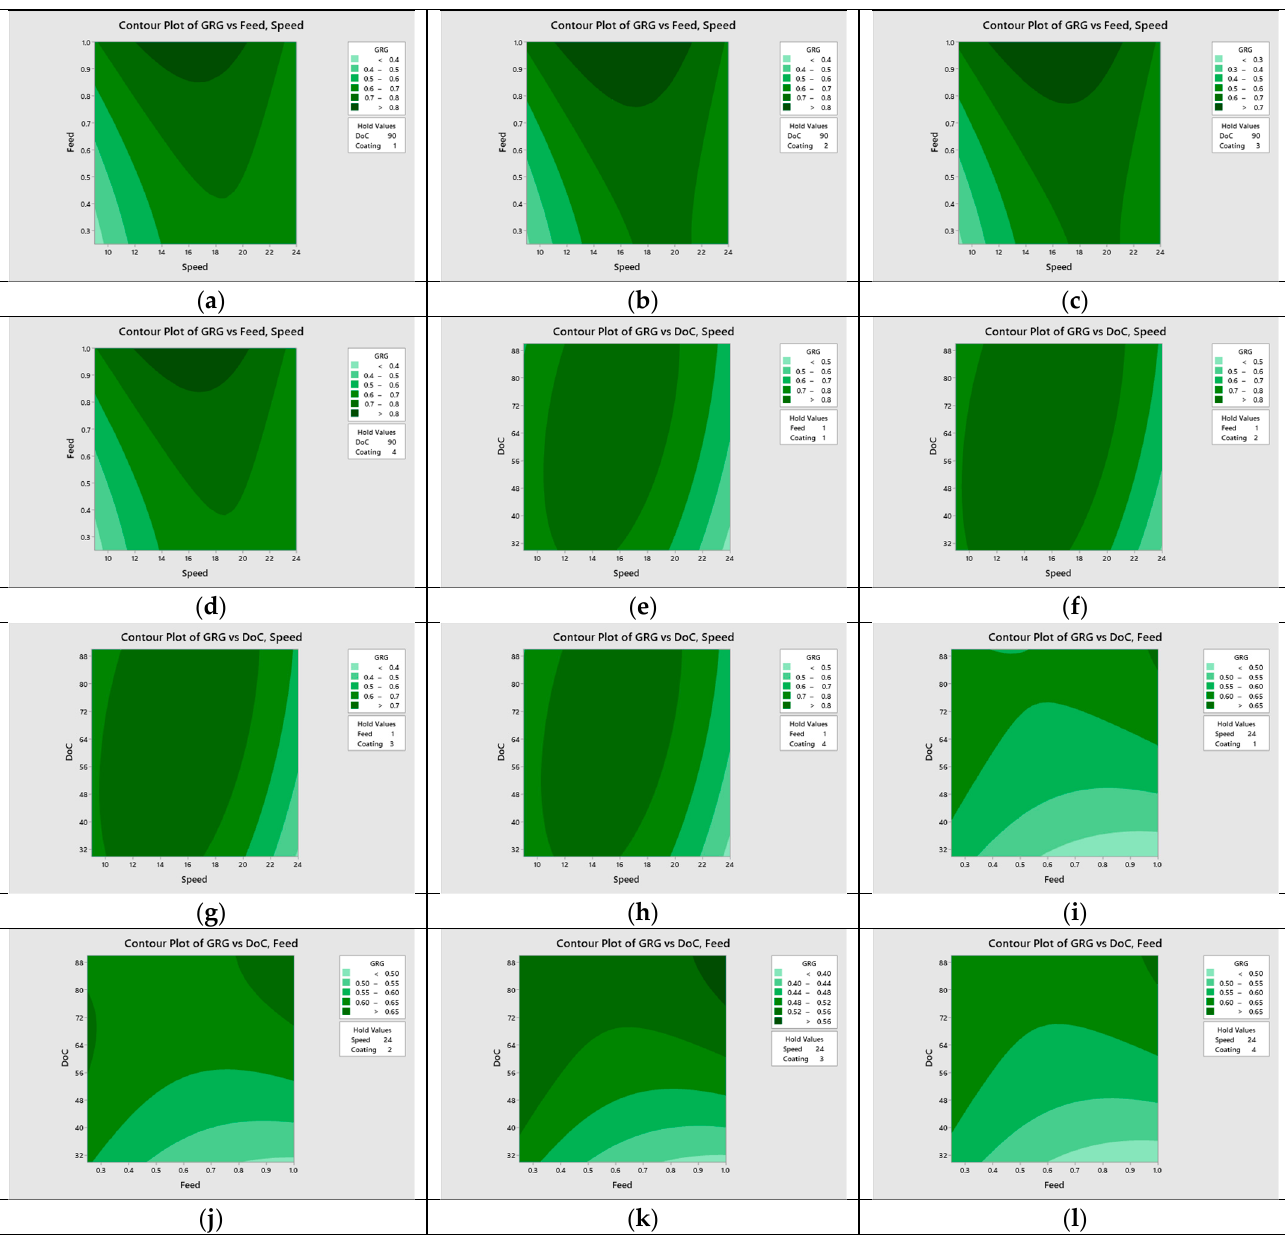
Table 6. Analysis of variance for regression model.